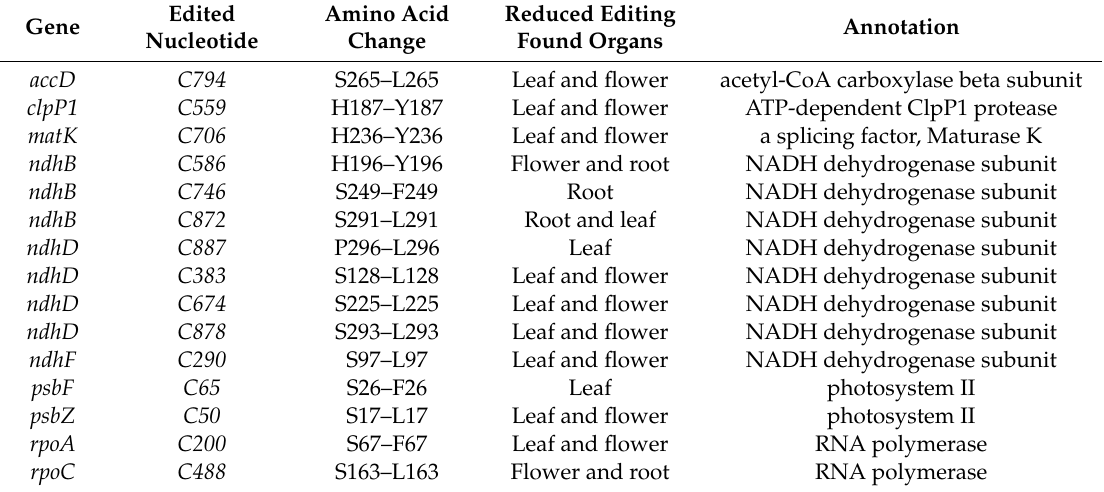
Table 1. Organ-dependent editing alterations in plastid genes encoding RNAs and proteins by loss of MORF9 in A.